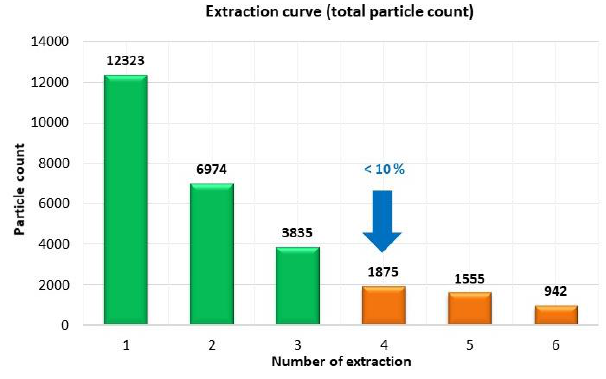
Fig. 8. Example of declining curve